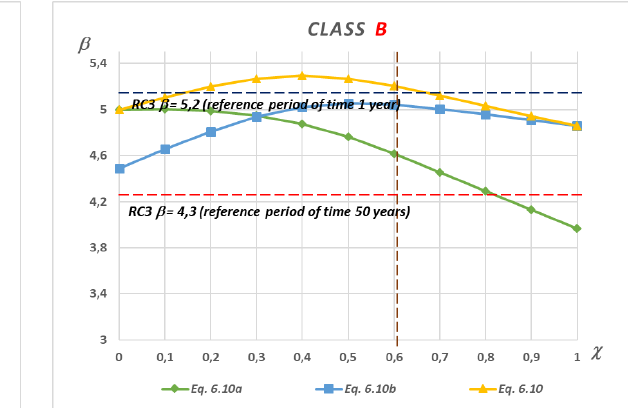
Figure 6: Reliability coeflcient curves β and load factor χ for the class B execution of works and three different combinations of